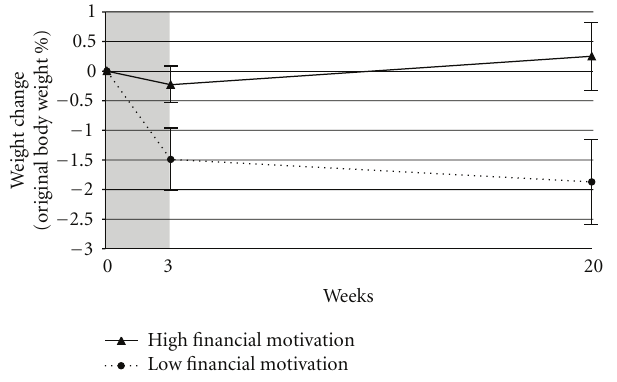
Figure 1: Financial motivation predicting weight change (% of original body weight). high: top quartile; low: bottom quartile. Table 2: Regression model predicting composite diet-activity score (diet-activity) at the end of follow-up (maintenance).